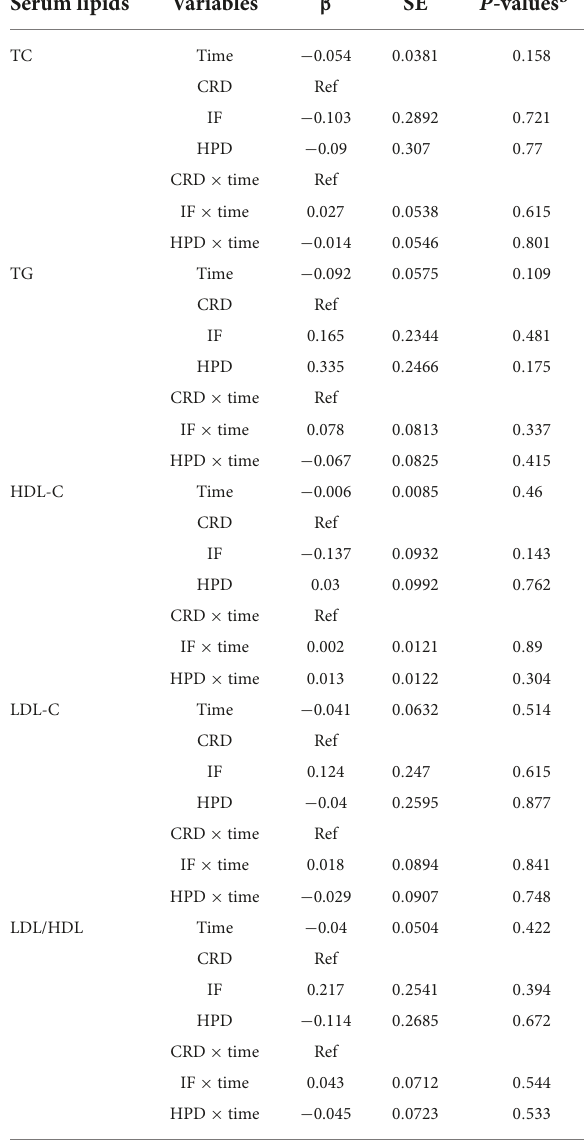
TABLE 3 Adjusted model for serum lipid results at baseline and 3 months among three groups in a randomized, placebo-controlled trial.